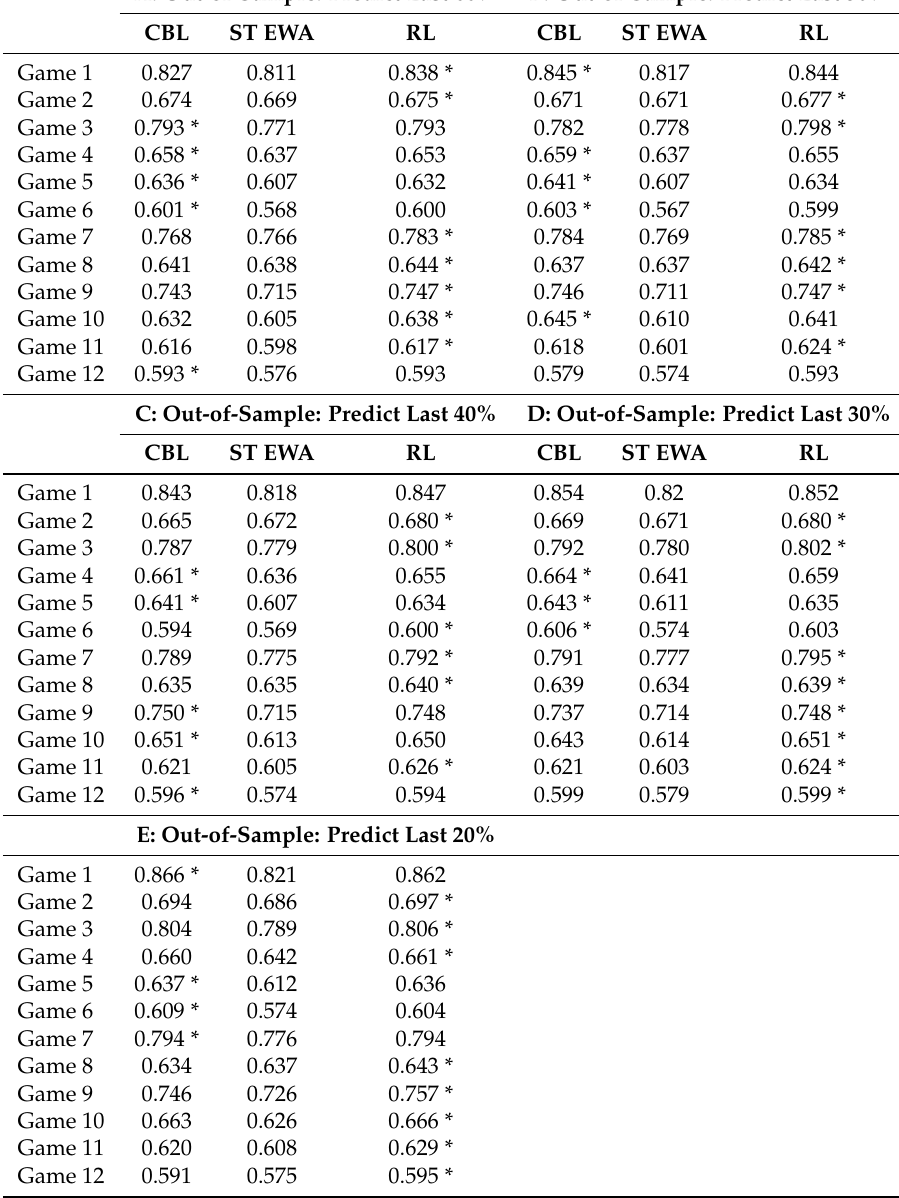
Table A4. Out-of-sample Fit by Game Note: * denotes the best fitting model based on the mean quadratic score. ST EWA refers to the self-tuning EWA, RL refers to reinforcement learning, and CBL refers to case-based